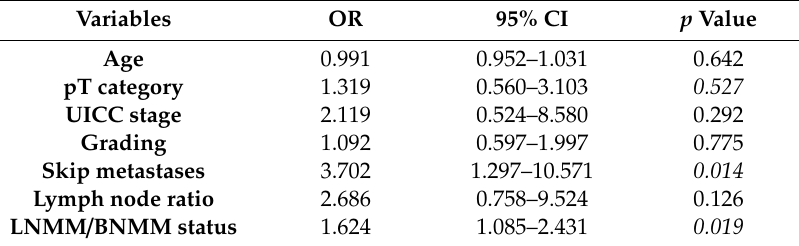
Table 4. Multivariate analysis for recurrence-free